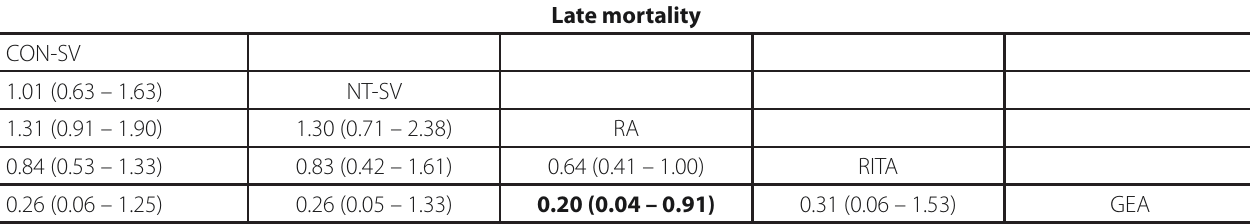
Table 4. League tables summarizing the results of the network meta-analysis (expressed as incidence rate ratio with 95% confidence interval) for late mortality using random effects